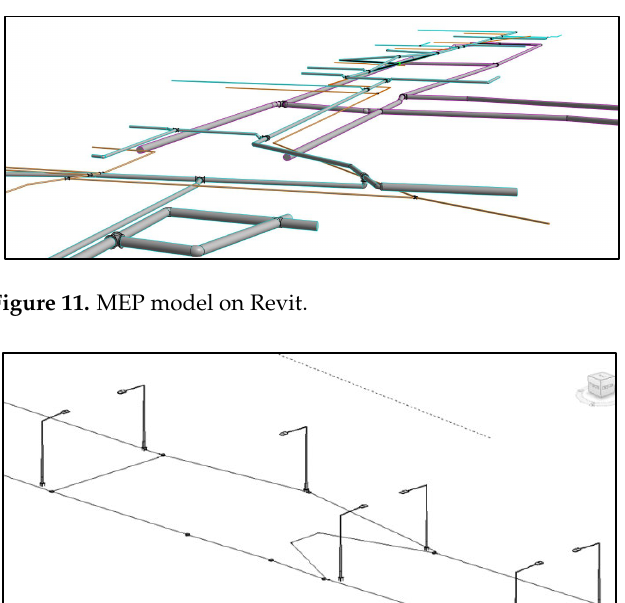
Figure 12. Public street lighting system model on Revit.